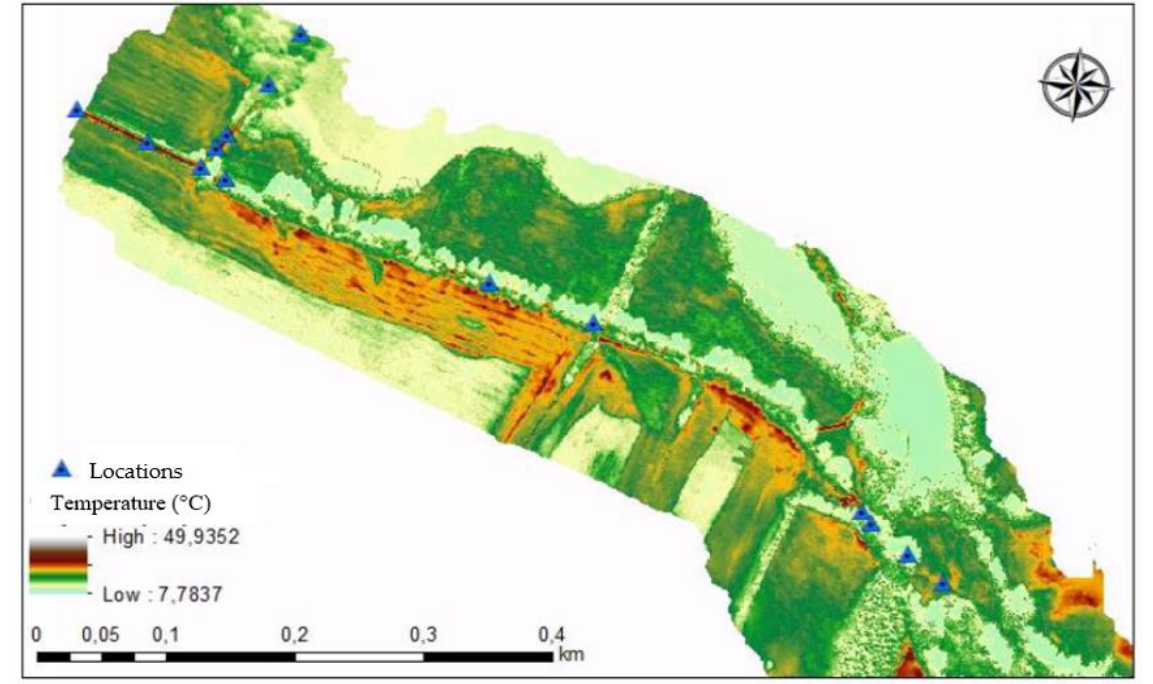
Figure 9. Heat map.